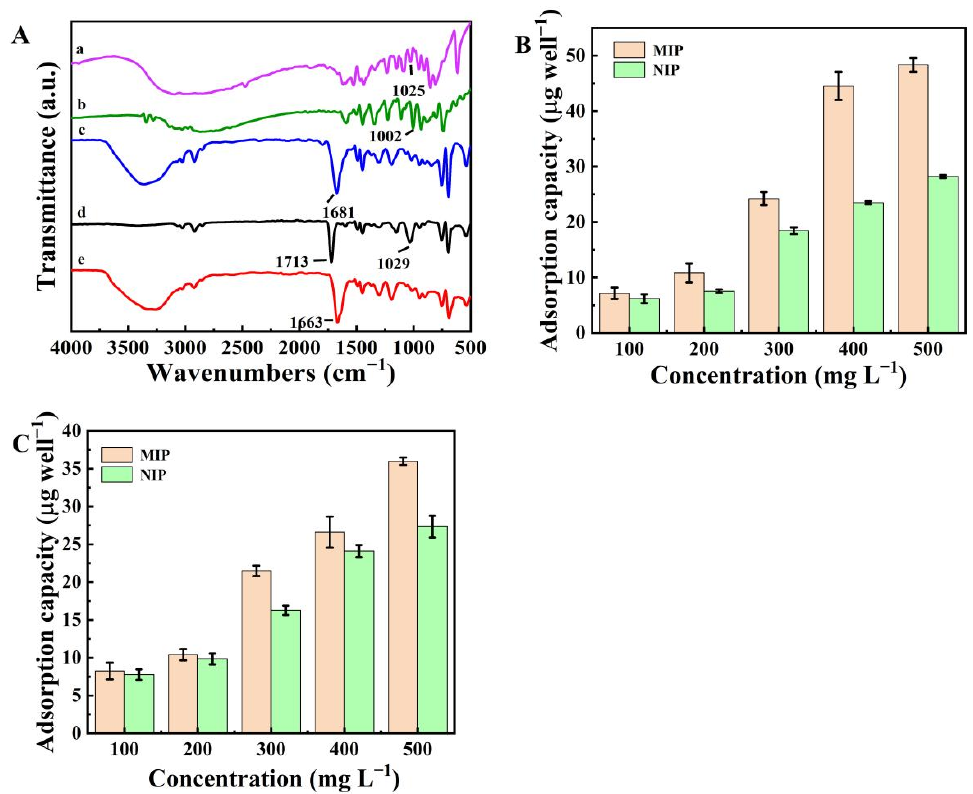
Figure 1. ( A ) FT-IR spectra for (a) histamine dihydrochloride, (b) tryptamine, (c) NIP, (d) MIP before elution, and (e) MIP after elution; ( B ) Adsorption isotherms for histamine on the MIP and NIP; ( C ) Adsorption isotherms for tryptamine on the MIP and